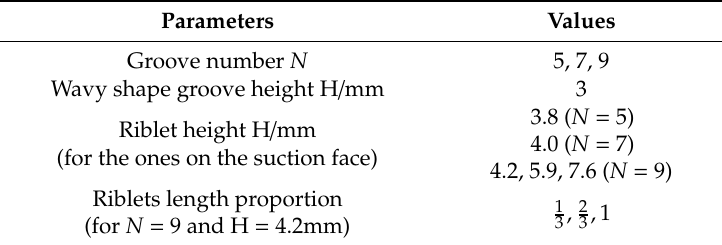
Table 2. Parameters of the biomimetic